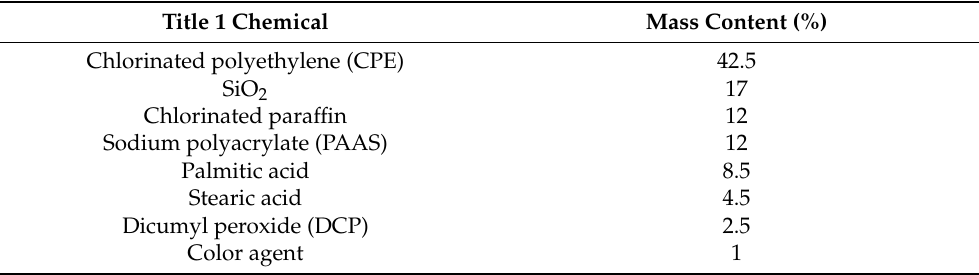
Table 1. Compositions of the hydrophilic gasket used in this